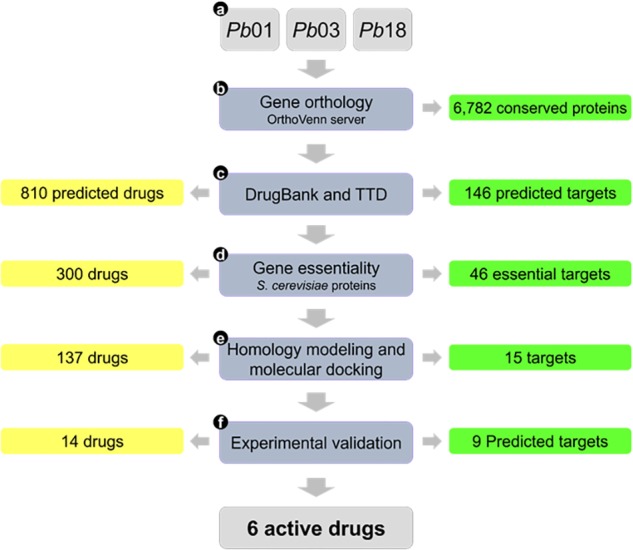
Flowchart summarizing the main steps of the study and corresponding results.